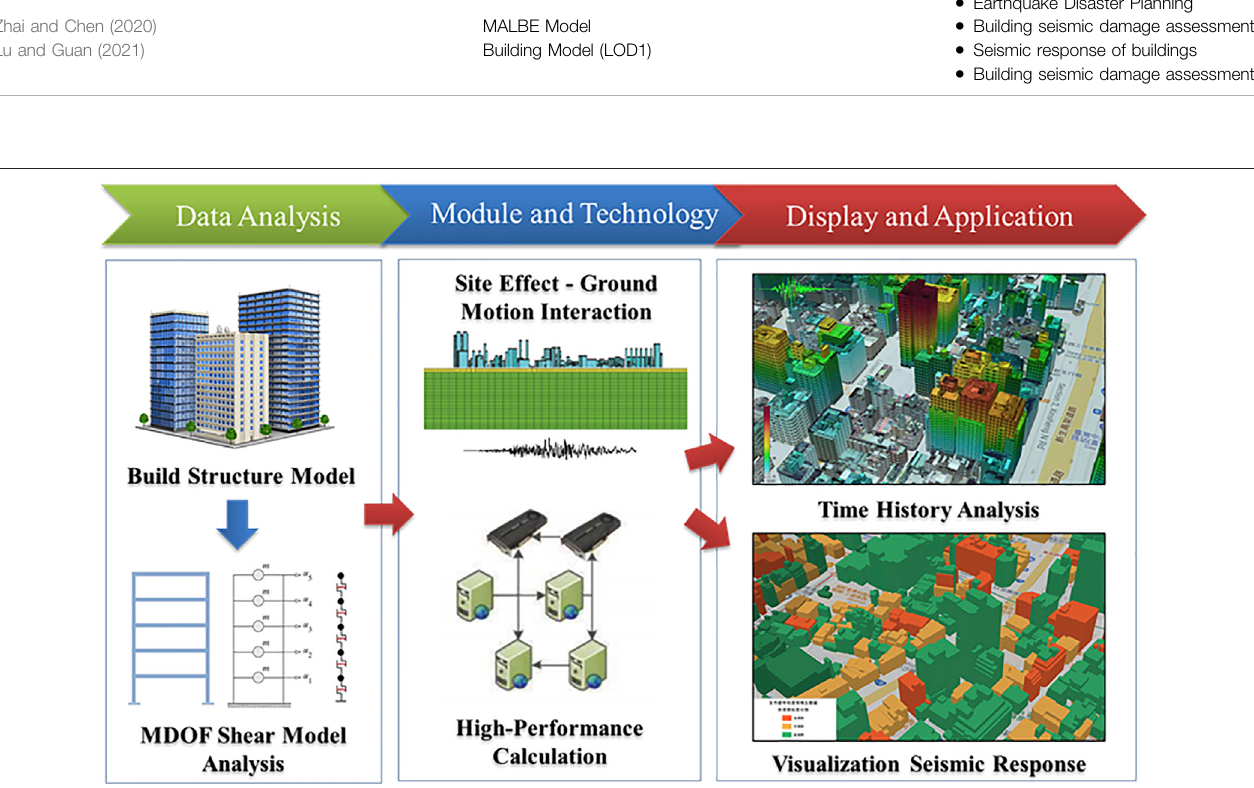
FIGURE 2 | Multi-dimensional visualization module for simulating earthquake